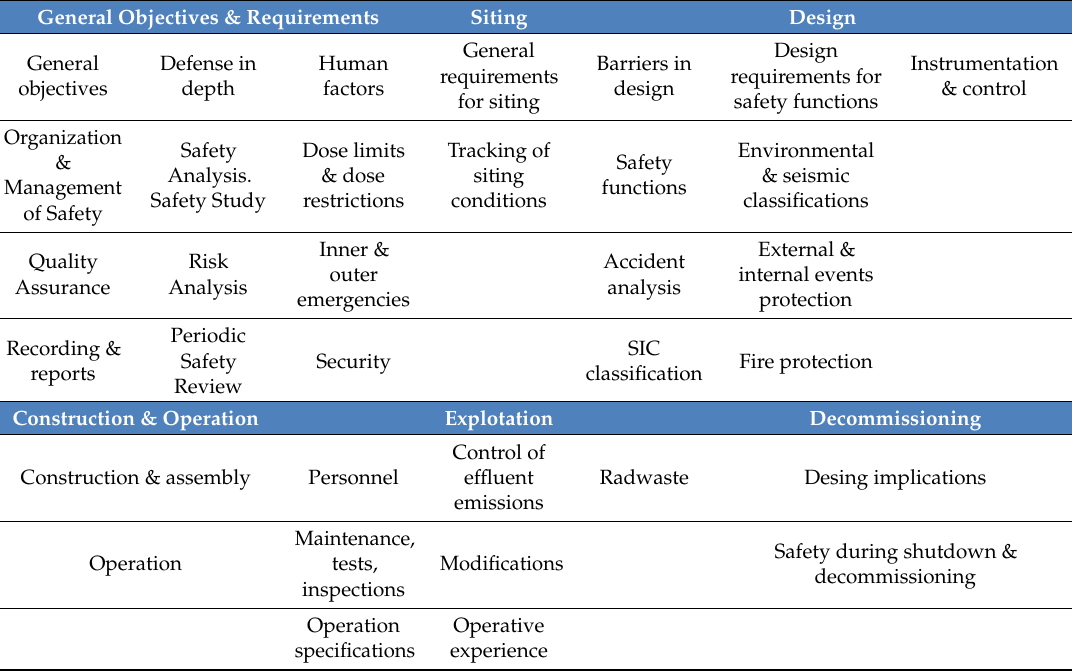
Table 1. Chapters and sections of ‘Safety Instruction